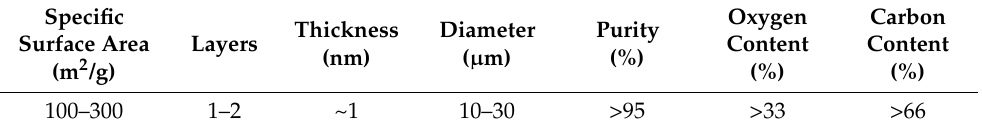
Table 2. Property parameters of GO.